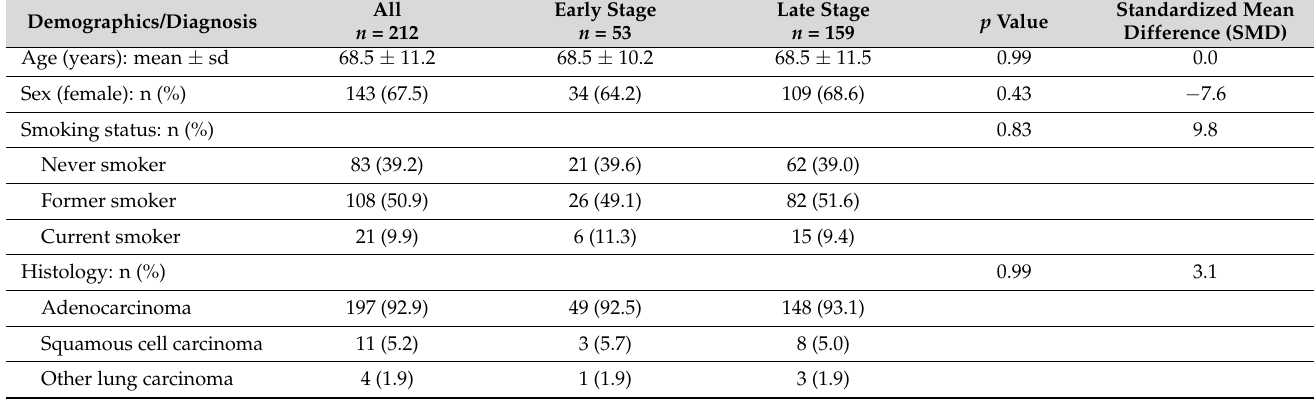
Table 2. Baseline characteristics by stage of NSCLC among matched patients.